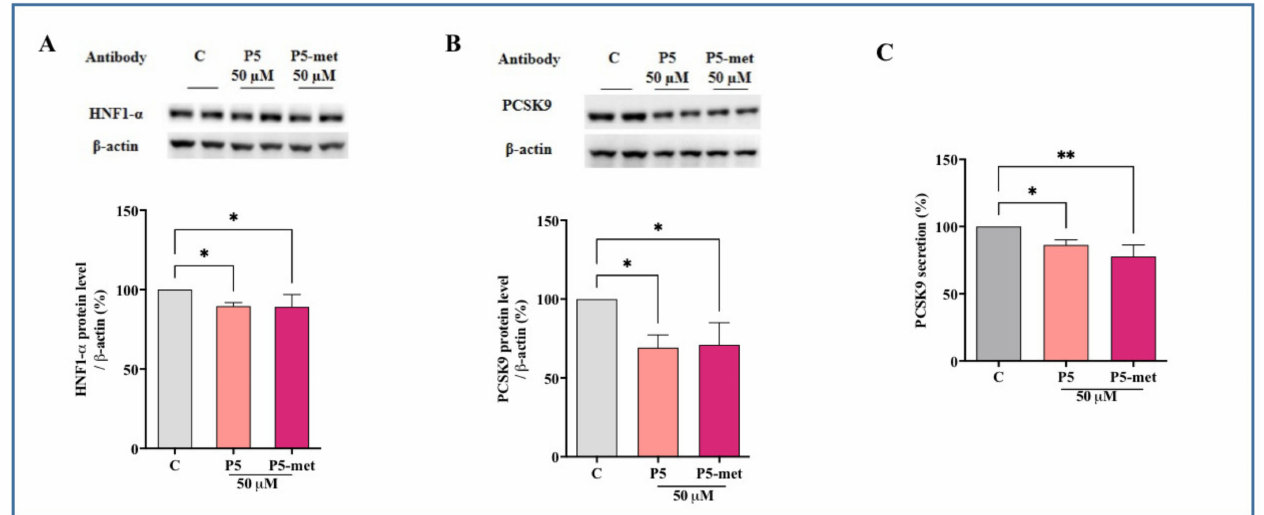
Figure 5. Modulation of PCSK9 pathway in HepG2 cells treated with P5 and P5-met. ( A ) Effects on the HNF1- α protein level; ( B ) effects on the PCSK9 protein levels; ( C ) effects on mature PCSK9 secretion. Data points represent the averages ± SD of six independent experiments performed in duplicate. C versus P5 and P5-met samples were analyzed by One-Way ANOVA followed by Dunnett’s test; (*) p < 0.05, (**) p < 0.01. C: control